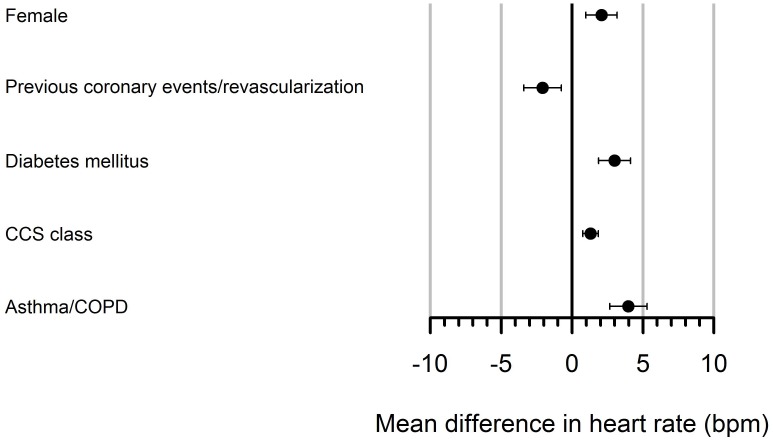
Regression estimates and confidence intervals resulting from multiple imputations and variable selections applied to the pooled data from ProCor I and ProCor II.Female denotes female gender.